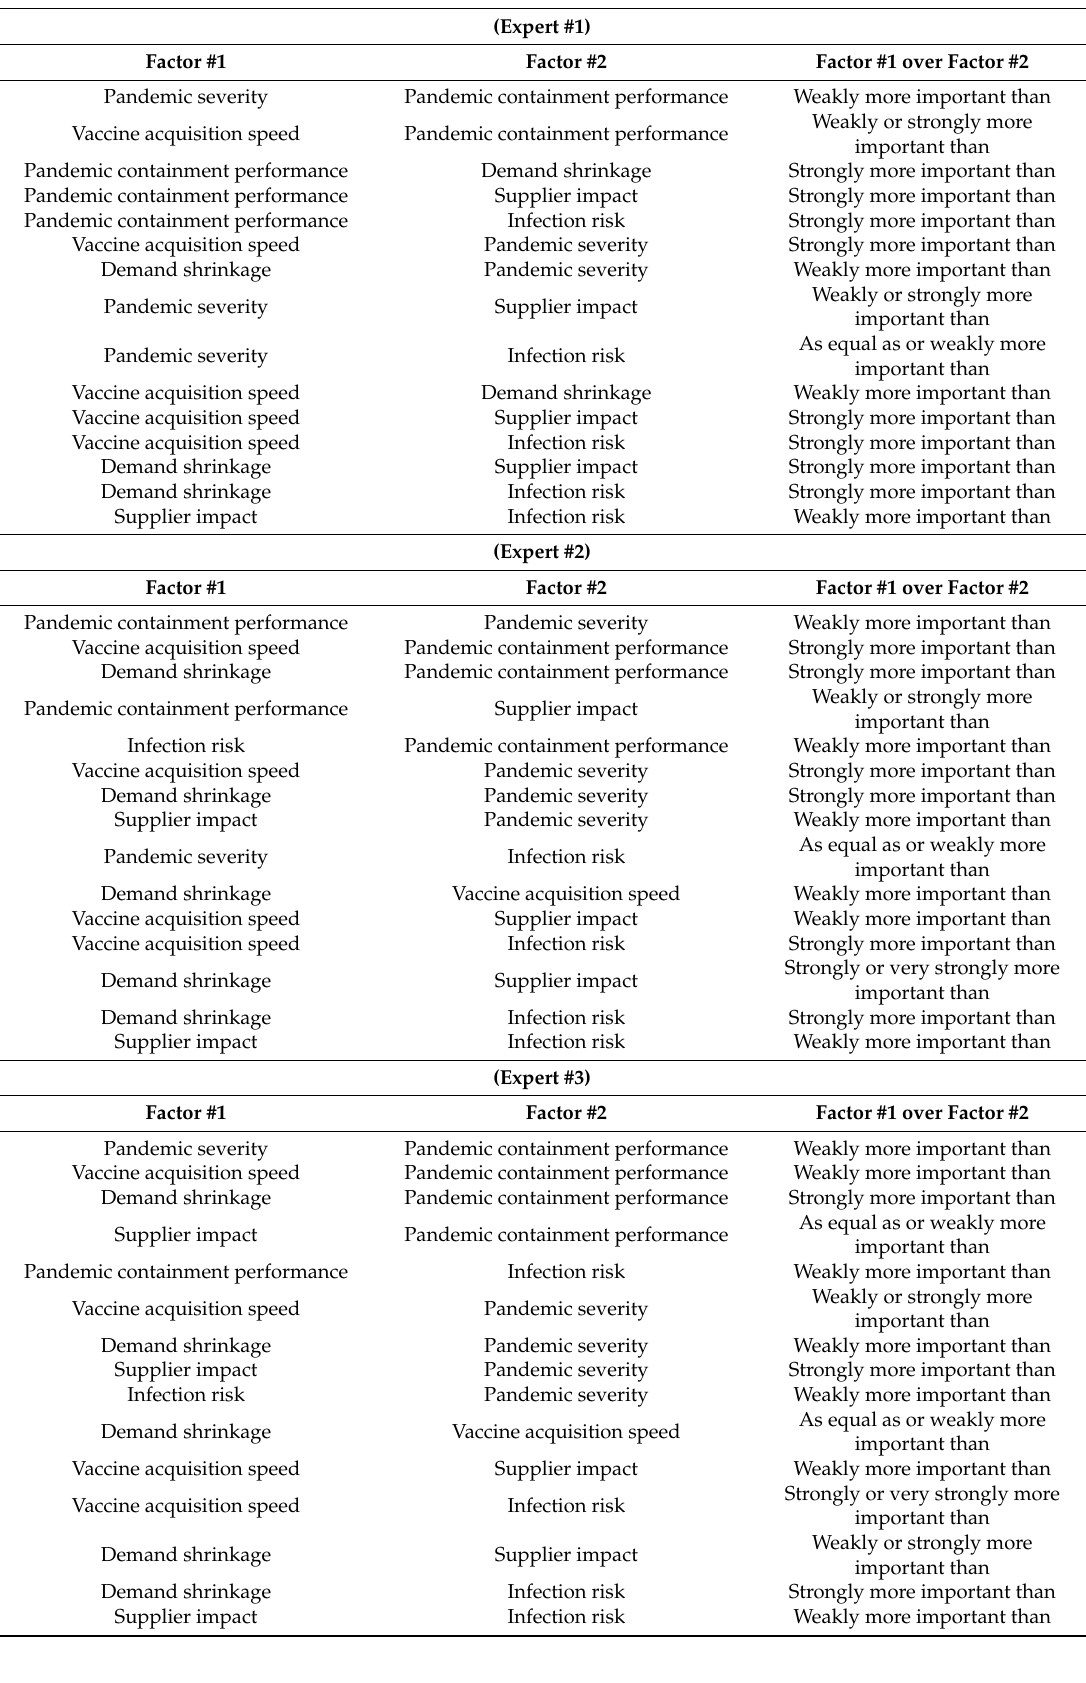
Table 2. Results of pairwise